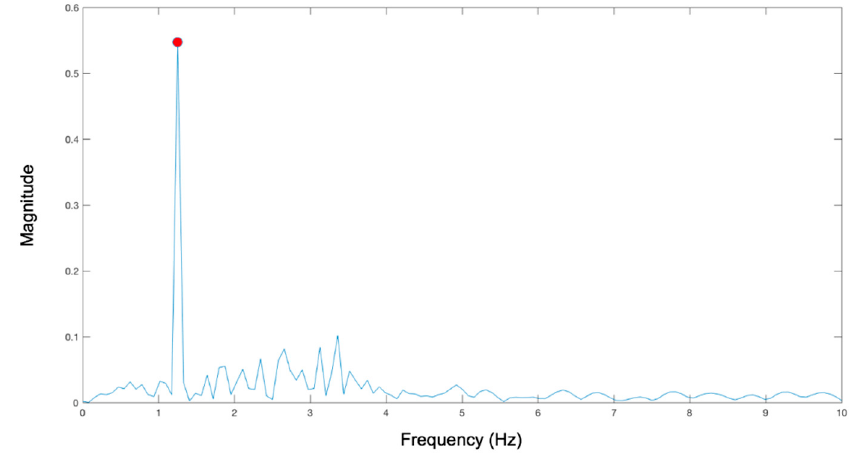
Figure 6. Result obtained from the analysis of the data with the fast Fourier transform (FFT) process.